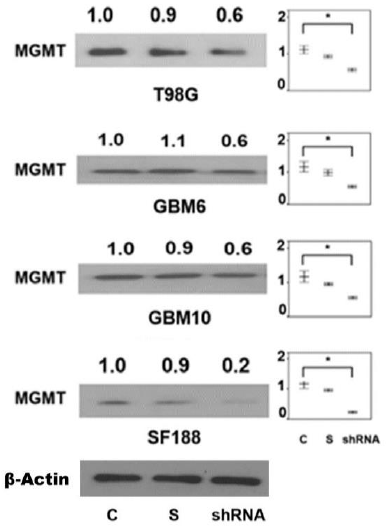
Figure 8. Marked downregulation of MGMT expression after silencing of the CTCF gene using an shRNA targeting the CTCF transcript variant 1 NM_006565.3 in 4 glioblastoma cell lines. Cells were transiently transfected with shRNA plasmids bearing CTCF-specific or a scrambled sequence for 24 h followed by western blotting. The mean expression of MGMT in 3 separate experiments was determined and shown in the side panels. Significant differences as determined by ANOVA are shown with an asterisk (*) from three independent experiments ( p < 001). Our findings, however, do not shed light on the exact mechanism(s) by which CTCF participates and promotes MGMT transcription. The CTCF binding site at the promoter may have a different function than the motifs present at the introns and exon 5 the of MGMT gene. As discussed earlier, human gliomas positive for IDH mutations manifest a CpG island methylator phenotype (G-CIMP) due to the inhibition of the TET-family of 5′- methylcytosine hydroxylases by the oncometabolite D-2HG [29]. When the IDH mutant gliomas develop increased methylation at CTCF binding sites, CTCF fails to bind to its motifs [69,71]. Given the known fact that cell lines/tumors with MGMT promoter methyl- ation poorly transcribe the gene, it is tempting to suggest that a compromised binding of CTCF envisaged in our RNA interference studies (Figures 7 and 8) may reflect the defi-